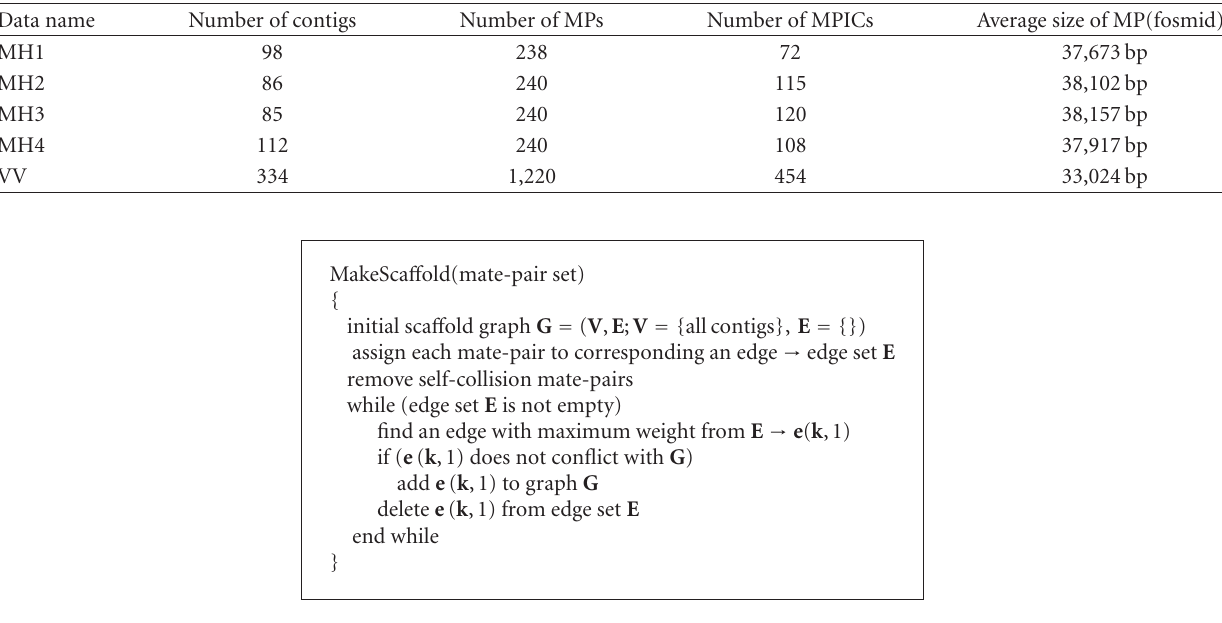
Algorithm 1: The algorithm for sca ff old construction. ConPath uses a simple greedy algorithm to obtain a feasible heuristic solution for an NP-complete problem.